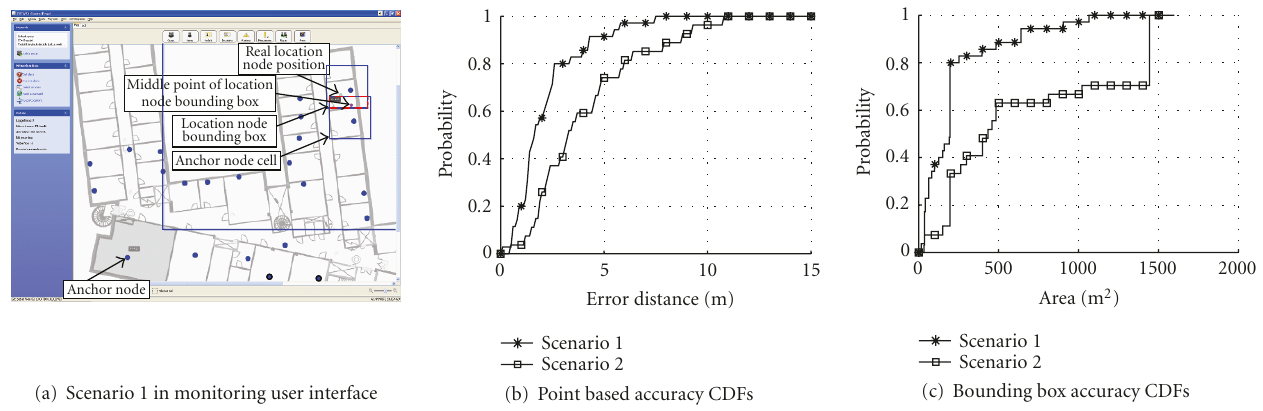
Figure 19: Localization test scenario 1 in user interface and cumulative distribution function results for point-based and bounding box accuracies in Scenario 1 (23 anchor nodes) and Scenario 2 (12 anchor